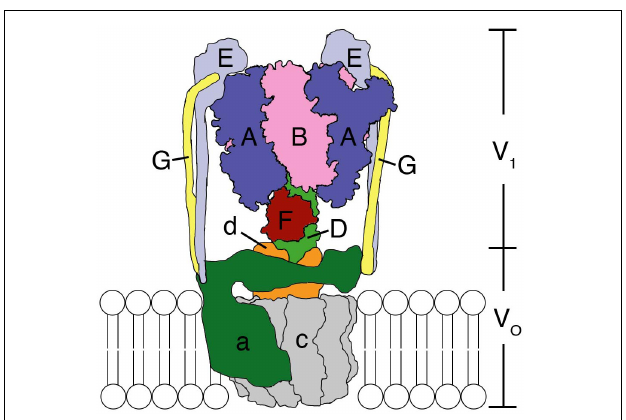
FIGURE 1 | Structural model of the Enterococcus hirae V-ATPase. A 3 B 3 hexamer ring with a DF shaft constitute the V 1 -ATPase catalytic part. The a subunit and c decamer rotor ring constitute the V o membrane-embedded part, which pumps out Na + from the cytoplasm. The EG peripheral stalks and d subunit connect and attach V 1 and V o . For details see